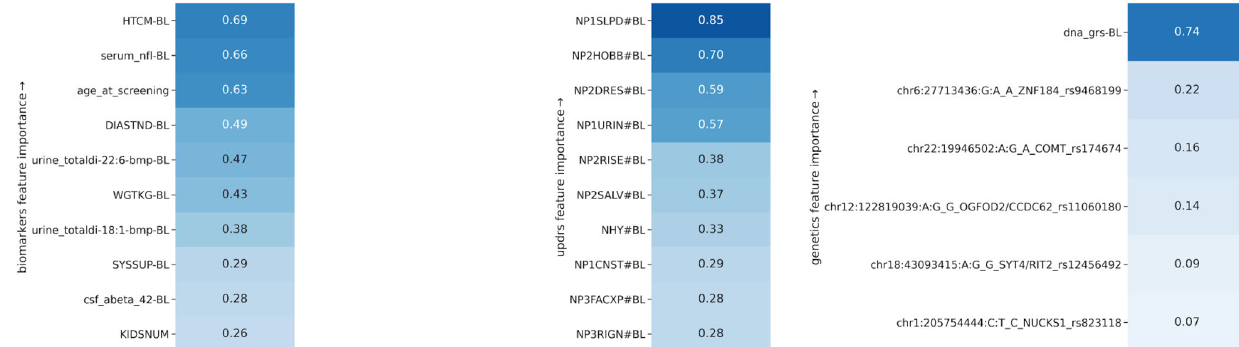
Fig. 8 Heatmap plot showing signi fi cant contributing clinical parameters (refer to Supplementary Table 6 for feature description) based on demographics, vital signs, baseline biospecimen, baseline MDS-UPDRS scores, and genetic measurements. The importance score of each feature is relative. BL baseline, HTCM height in cm, serum_n fl serum neuro fi lament light levels, age_at_screeing Age at screening, DIASTND standing diastolic blood pressure (BP), urine_totaldi urine levels of di-22:6-bis (monoacylglycerol) phosphate, WGTKG weight in kg, SYSSUP supine systolic BP, csf_abeta_42 cerebrospinal fl uid β -amyloid 1 – 42, KIDSNUM number of kids, dna_grs genetic risk